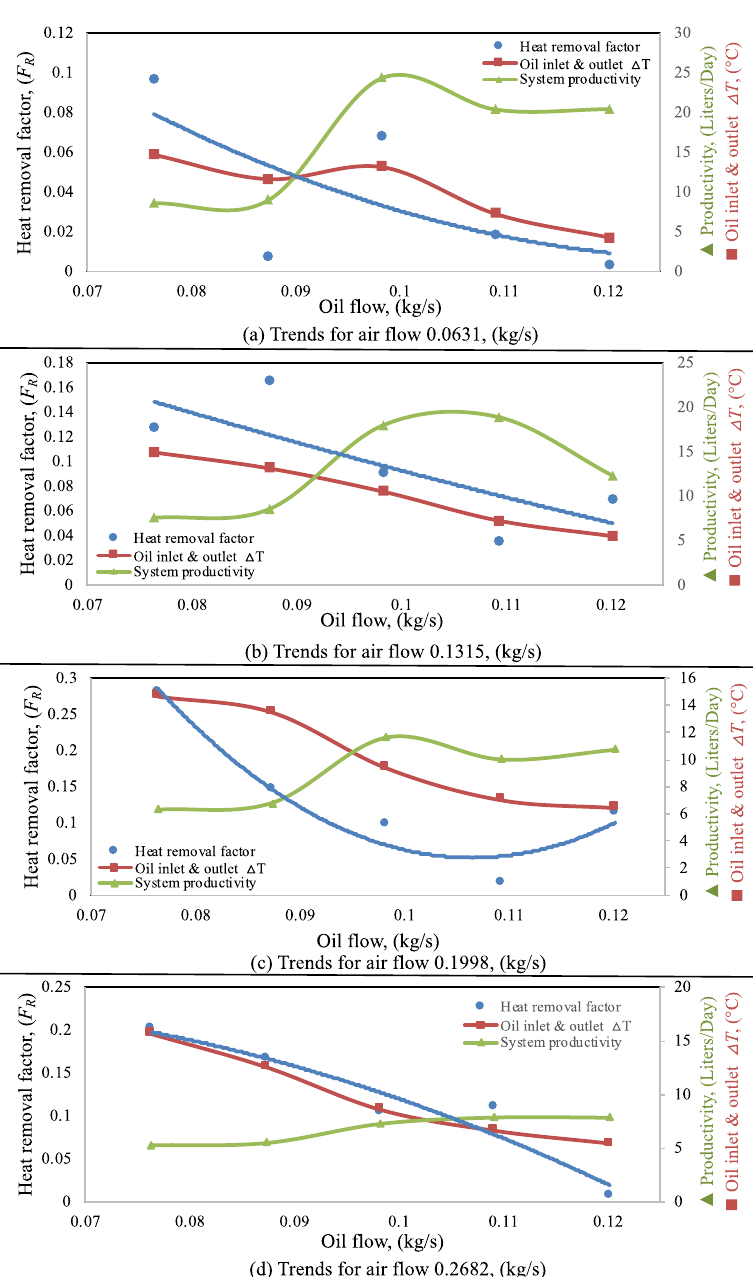
Figure 23. Heat removal factor F R of the PTCs with the change of system productivity and oil Δ T at different air and oil flow rates.